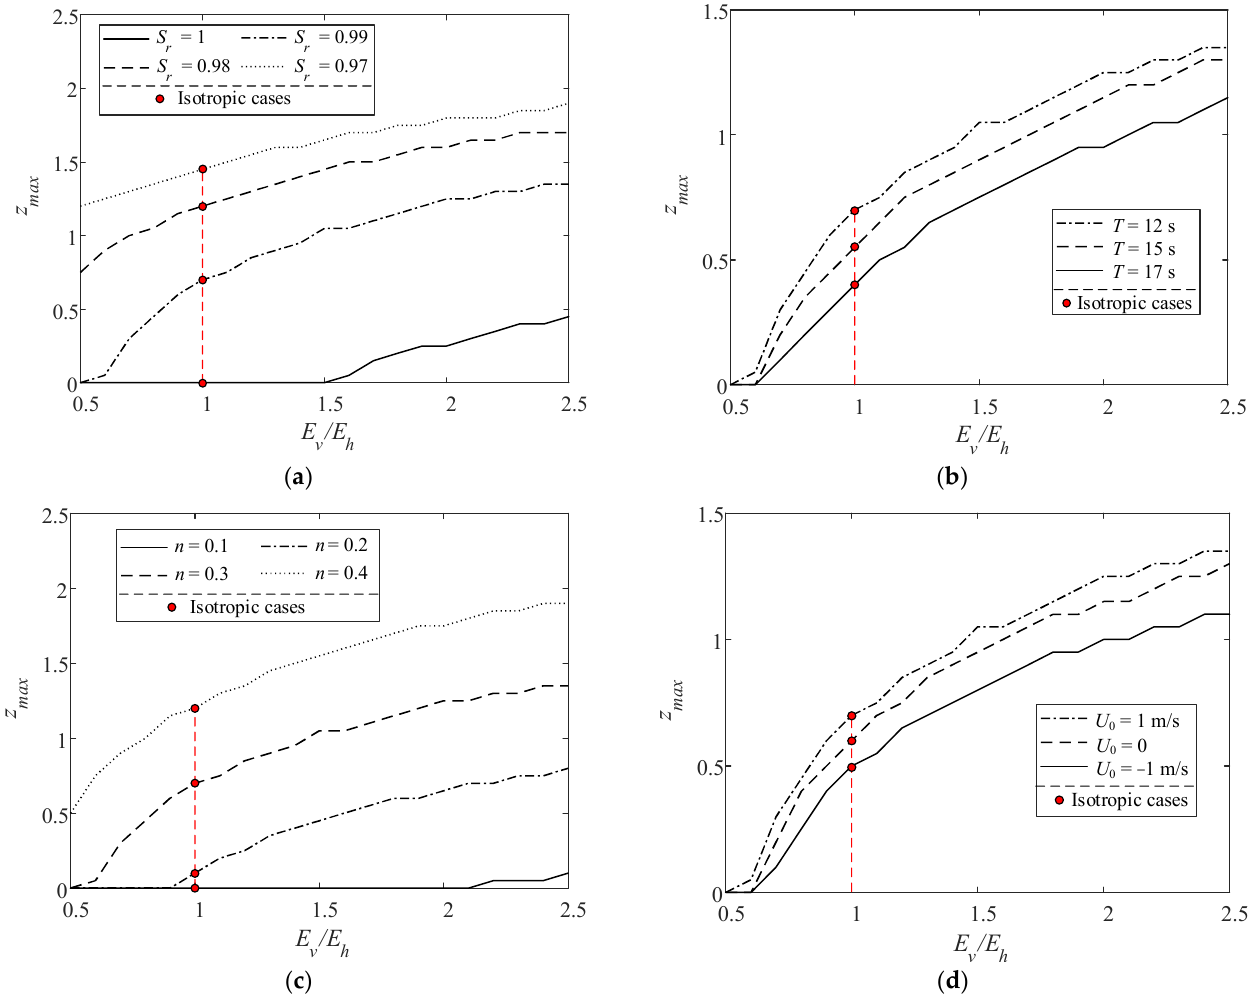
Figure 12. Maximum liquefaction depth z max varying with E v /E h for various ( a ) degrees of saturation, ( b ) wave periods, ( c ) soil porosities, ( d ) current velocities. Figure 13 shows the vertical distributions of normalized | p| , | τ xz |, | for various ratios of vertical shear modulus to vertical Young’s modulus G v /E v , where G v /E v = 1/2.6 and corresponds to the isotropic case. A fixed value of E v = 2.6 × 10 7 Pa is chosen. Similar to E v / E h , G v /E v changes all vertical distributions of | p| , | τ xz |, | Especially, z max at | xx σ | = 0 is more significantly affected by G v /E v than by K v / K h and E v / E h , referring to Figures 9d, 11d, and 13d. ( a )